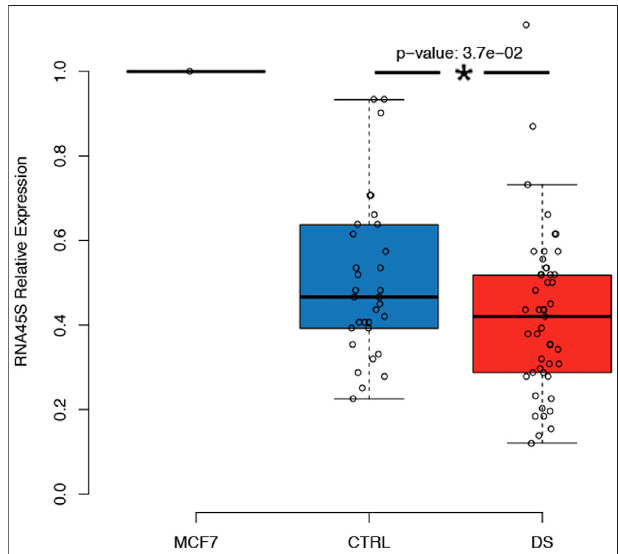
FIGURE 6 | Expression of the RNA45S precursor in persons with DS. The boxplot reports the relative expression of RNA45S in CTRL and DS. RNA45S expression was measured using a standard ΔΔ CT approach in whichexpressiondatawere fi rstnormalizedtoanendogenousgene,the GUSB gene, and then to an internal calibrator consisting of an MCF7 cell line. P -value was determined by an ANOVA test with correction for age and